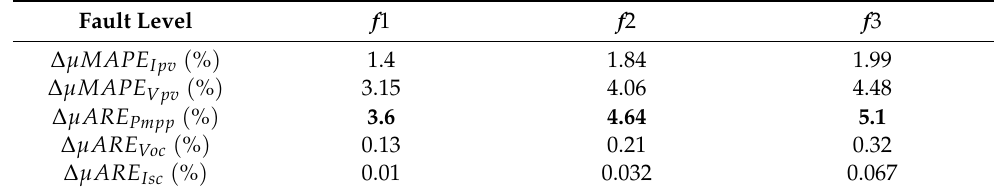
Table 16. Effect of the R s on the I–V curve characteristics.